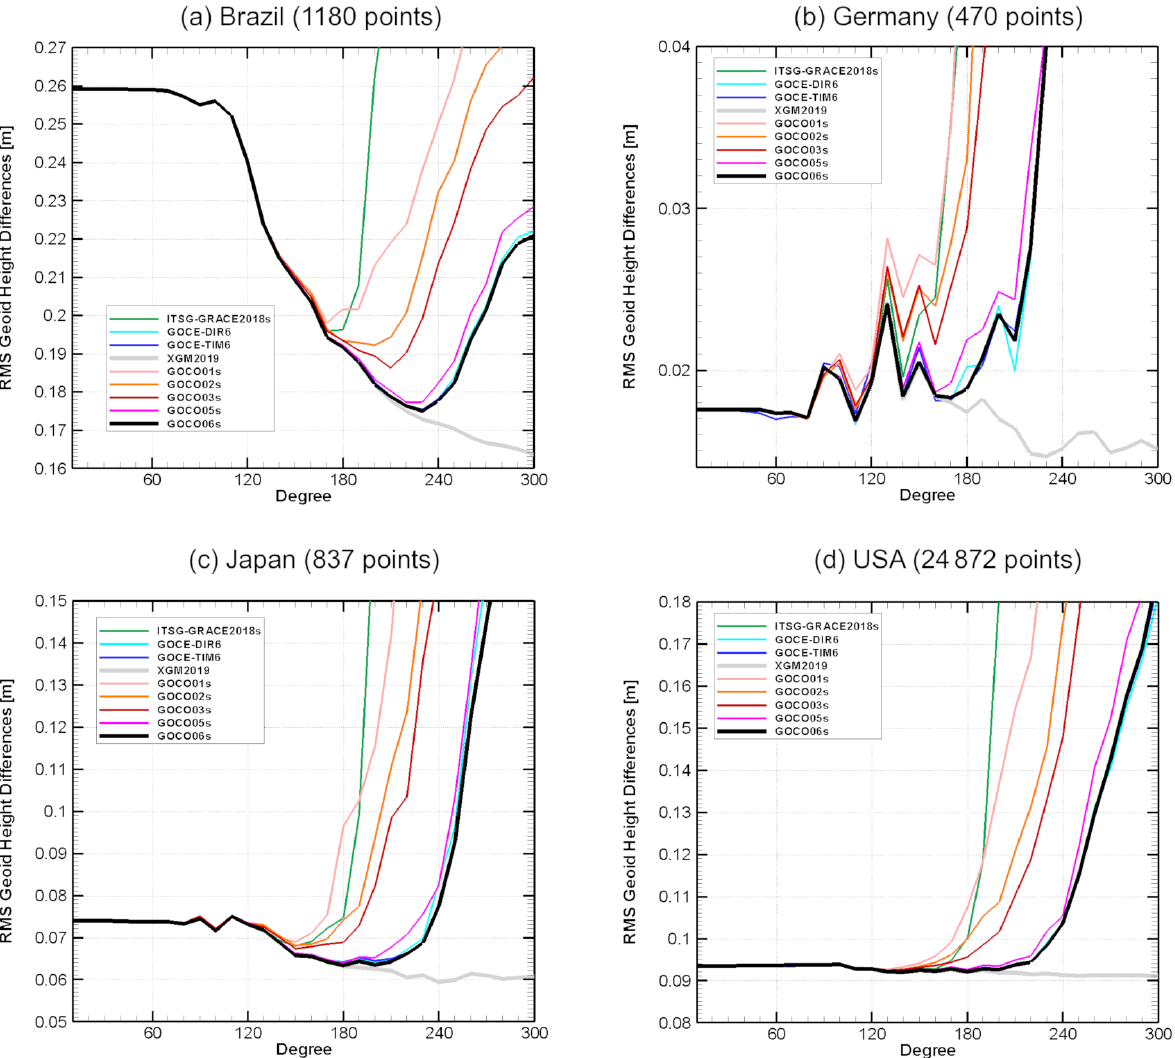
Figure 10. Root mean square of geoid height differences between global gravity models and independently observed geoid heights from GNSS leveling. Global models are truncated with steps of 10 ◦ starting from degree and order 10 to degree and order 300. The omission error is computed from the degree of truncation to degree and order 2190 from EGM2008 and from the ERTM2160 topographic gravity field model for degrees above